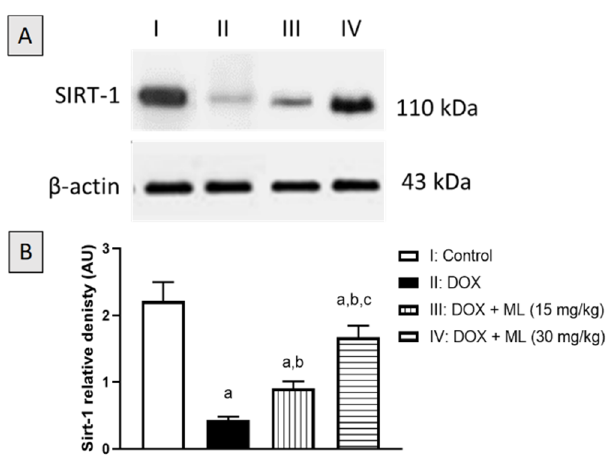
Figure 8. ( A ) Western blot analysis of Sirt-1 and β -actin expression in liver tissues. I: Control,